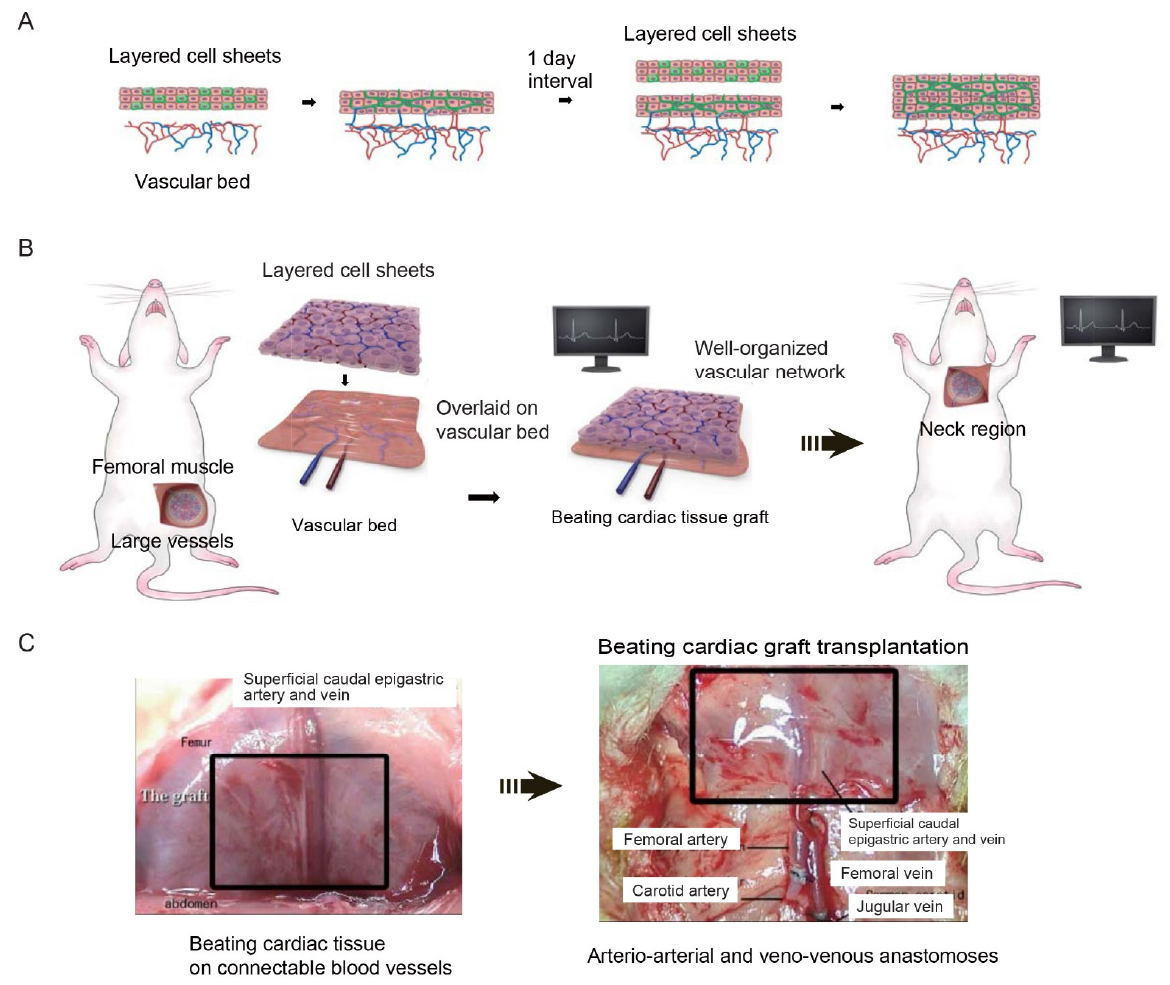
Figure 4. Construction of thick cardiac tissue grafts with blood vessels by the sequential implantation of multiple car- diomyocyte sheets containing vascular endothelial cells. ( A ) A three-layered cardiac cell sheet containing endothelial cells is transplanted onto a vascular bed. One day later, after a capillary network has formed in the cardiac tissue graft, a new three-layered cardiac cell sheet containing endothelial cells is transplanted on top of the original cardiac cell sheet. Thick myocardial tissue with a capillary network is constructed by repeating this procedure multiple times. ( B ) Fabrication of cardiac tissue suitable for ectopic transplantation. Three-layered cardiomyocyte sheets containing endothelial cells are repeatedly grafted onto existing large vessels in vivo to create pulsatile cardiac tissue supplied by an artery and vein. ( C ) A vascularized cardiac tissue graft is fabricated by the repeated implantation of three-layered cardiomyocyte sheets onto the femoral muscle of a rat. The cardiac tissue graft and accompanying femoral blood vessels are then excised and implanted into a region of the neck by anastomosis of the femoral blood vessels with neck vessels. Pulsation of the graft resumes immediately after vascular anastomosis. Reproduced with permission, Copyright 2006 Federation of American Societies for Experimental Biology. The schematic diagram was drawn with the graphic design software, Adobe